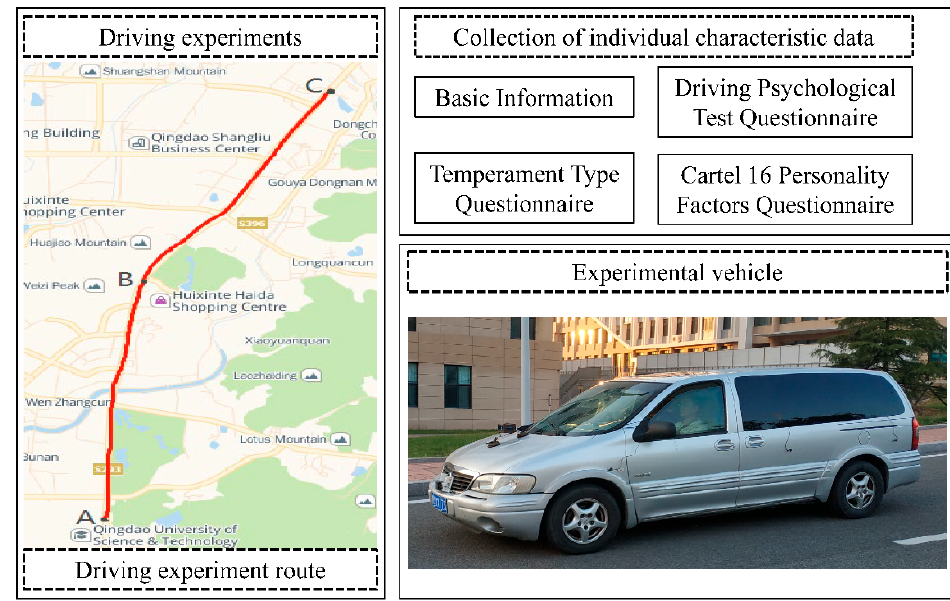
Figure 2. Experimental